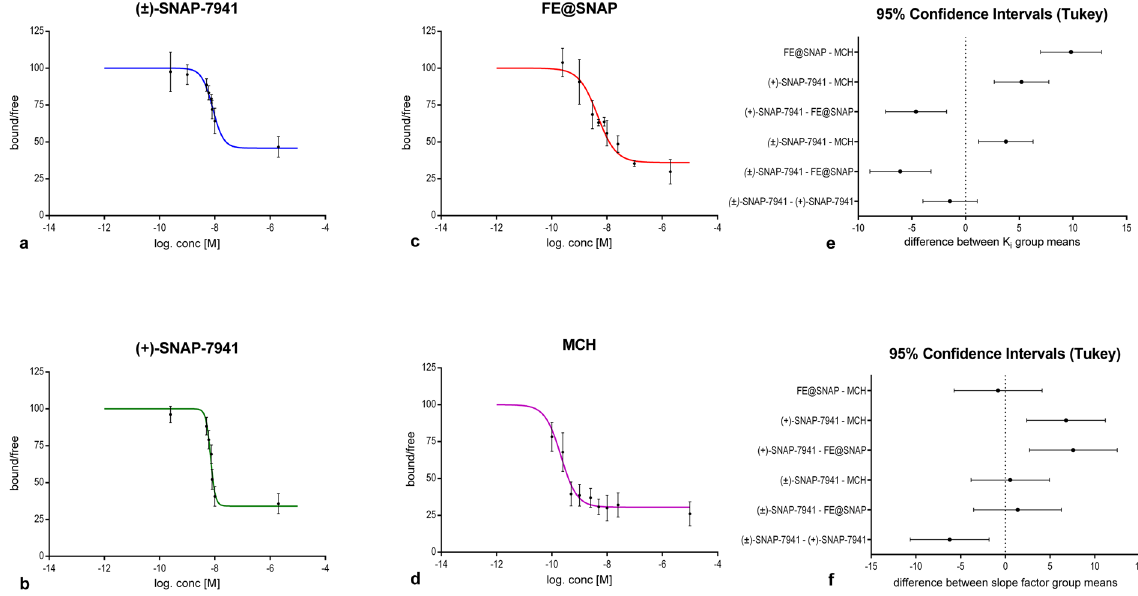
Figure 2. Competitive binding studies. Displacement of specific [ 125 I]MCH binding on CHO-K1 cell membranes expressing the hMCHR1 in presence of different concentrations of ( ± )-SNAP-7941 ( a ), ( + )-SNAP- 7941 ( b ), FE@SNAP ( c ) and MCH ( d ). Differences between group means of the K i ( e ) and the dedicated Hill slope factor ( f ) with corresponding 95% confidence intervals. Data are plotted as mean ± SEM from three independent experiments each performed in quadruplicate. If not visible the error bars are within the margin of the symbols.